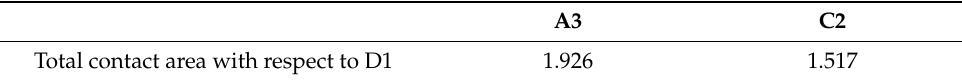
Table 8. Total contact area value with respect to D1.